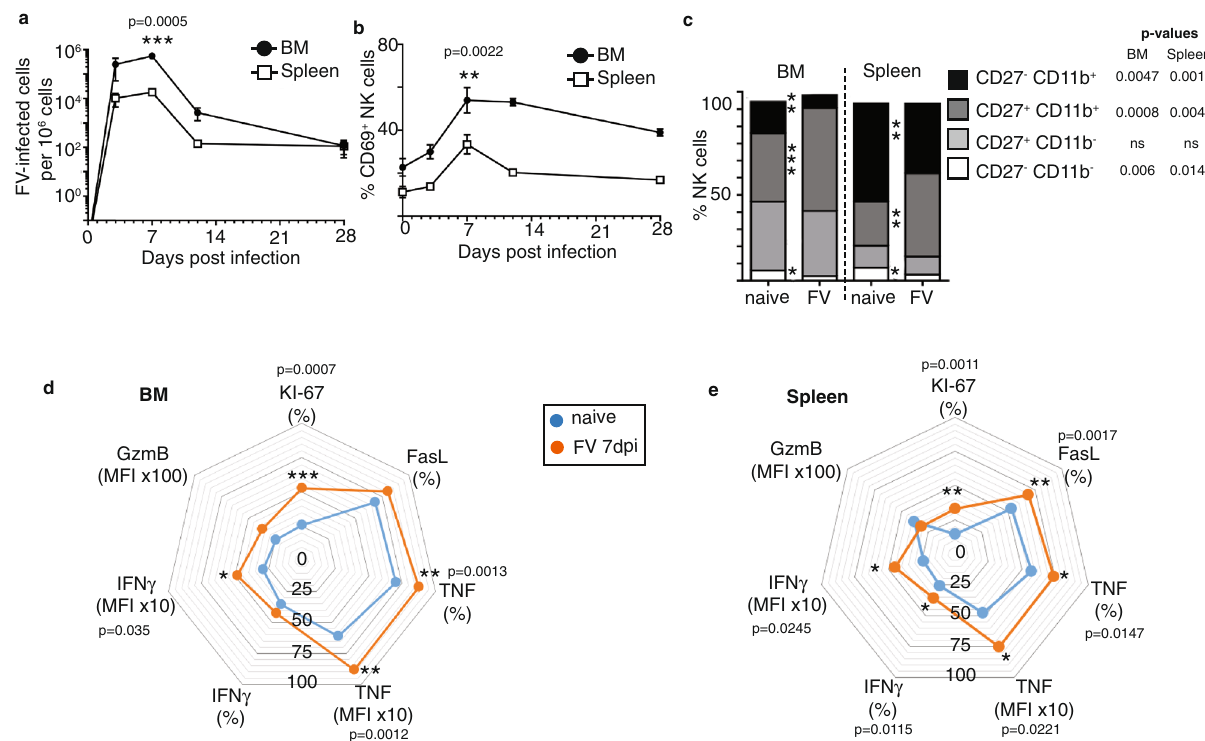
Fig. 1 Kinetic of FV infection and effector phenotype of NK cells upon FV infection. C57BL/6 mice were infected with FV for 3, 7, 12 and 28 days. Single- cell suspensions from spleens and bone marrow (BM) were prepared and used for the analysis of viral loads via Infectious Center assay ( a ). At least six mice from at least two individual experiments were used for the analysis. b Single-cell suspensions were stained for NK cell markers (CD3 − NK1.1 + CD49b + ) and analysed for the activation by measuring the early activation marker CD69. Naive mice were used as control. Mean values ± SEM were indicated by circles (bone marrow) and rectangles (spleen). Statistically signi fi cant differences between bone marrow and spleen ( a ) and CD69 + NK cells ( b ) were analysed by Mann – Whitney test. At 7 dpi, splenocytes were stained for NK cell markers and CD27 and CD11b ( c ). The effector phenotype of splenic NK cells ( e ) and NK cells from the bone marrow ( d ), KI-67, FasL, TNF, IFN γ and GzmB is displayed as spider plots. Data of NK cells from naive mice were displayed in blue and from FV infection in red. Statistically signi fi cant differences were analysed between naive and FV groups with an unpaired t -test (CD27 CD11b, KI-67, FasL, TNF (%), IFN γ (%)) or Mann – Whitney test (TNF (MFI), IFN γ (MFI)) within the bone marrow or spleens. A minimum of six mice from two independent experiments was used for the analysis. Signi fi cances are indicated as follows: * p < 0.05, ** p < 0.01, *** p < 0.001. Applied